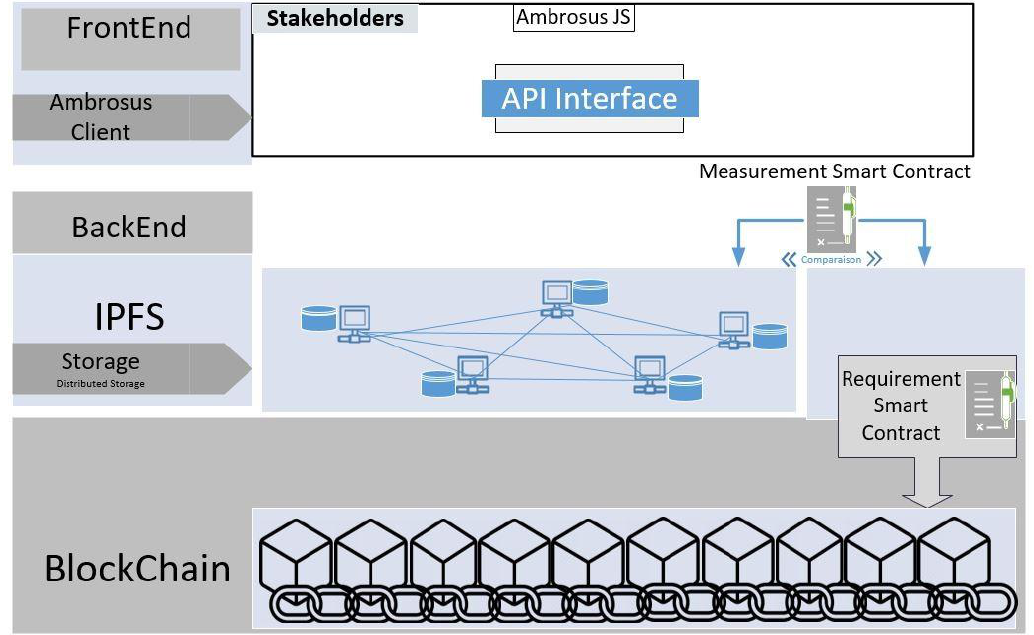
Figure 5. Ambrosus